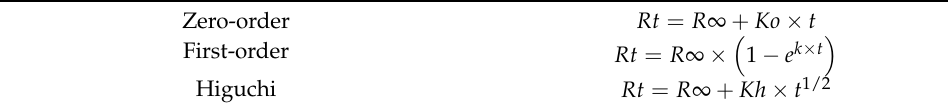
Table A1. Equations of the kinetic models fitted.